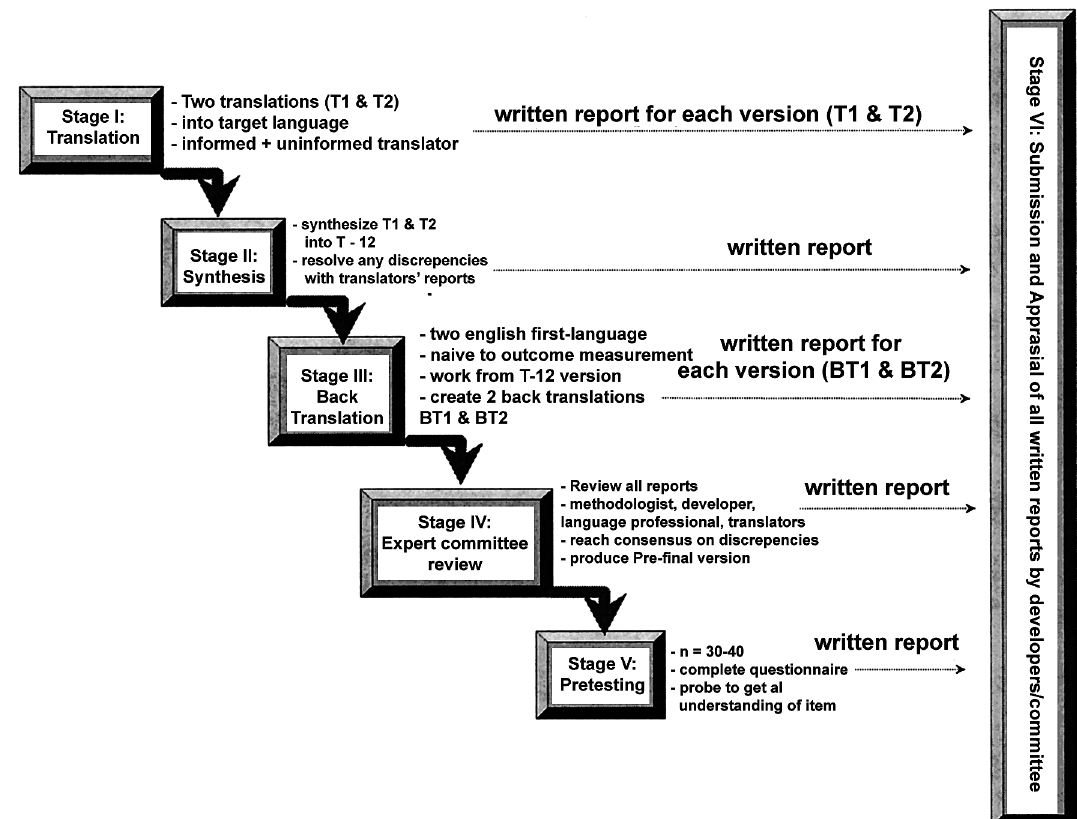
Figure 1 – Graphic representation of the stages of cross-cultural adaptation